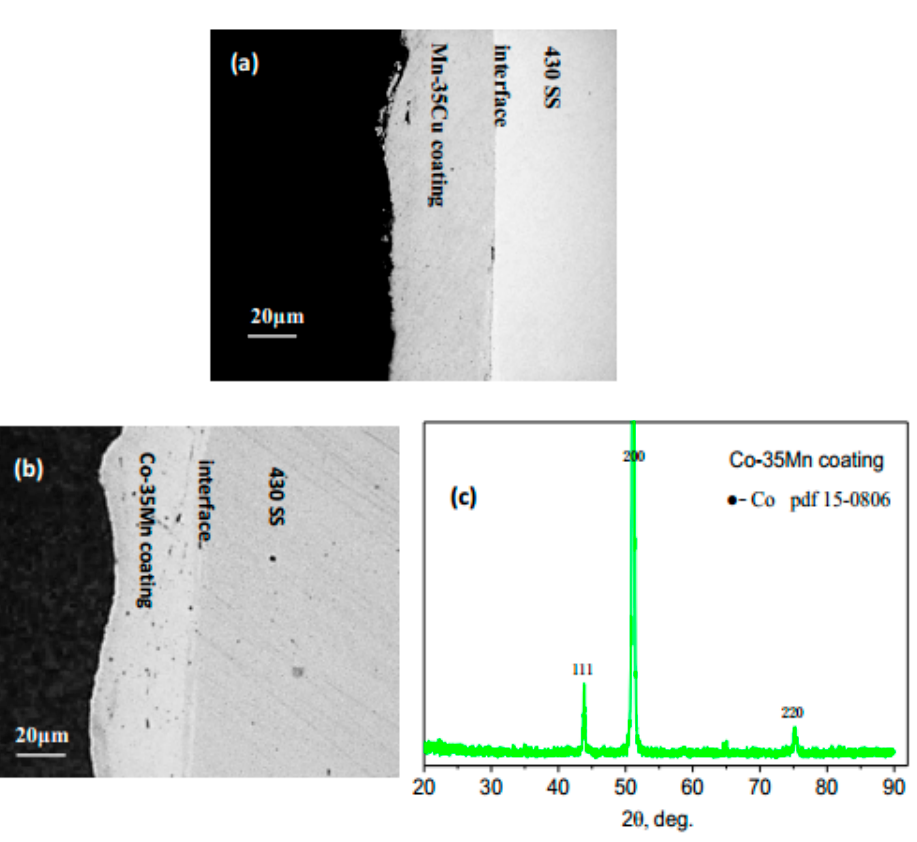
Figure 2. ( a ) Cross-section morphology of Mn-35Cu coating deposited by HEMAA, ( b ) cross section of Co-35Mn coating deposited by HEMAA, and ( c ) X-ray diffraction of Co-35Mn